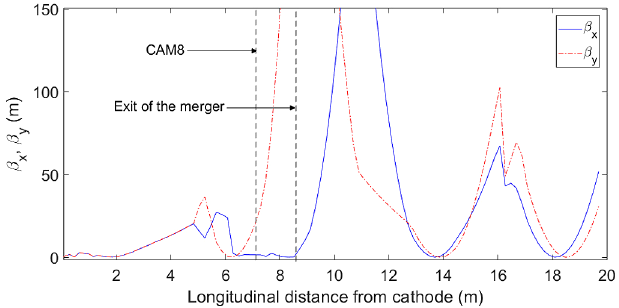
FIG. 10. The horizontal (solid line) and the vertical (dotted- dashed line) betatron functions of the recirculation loop from the electron gun up to the exit of the main linac